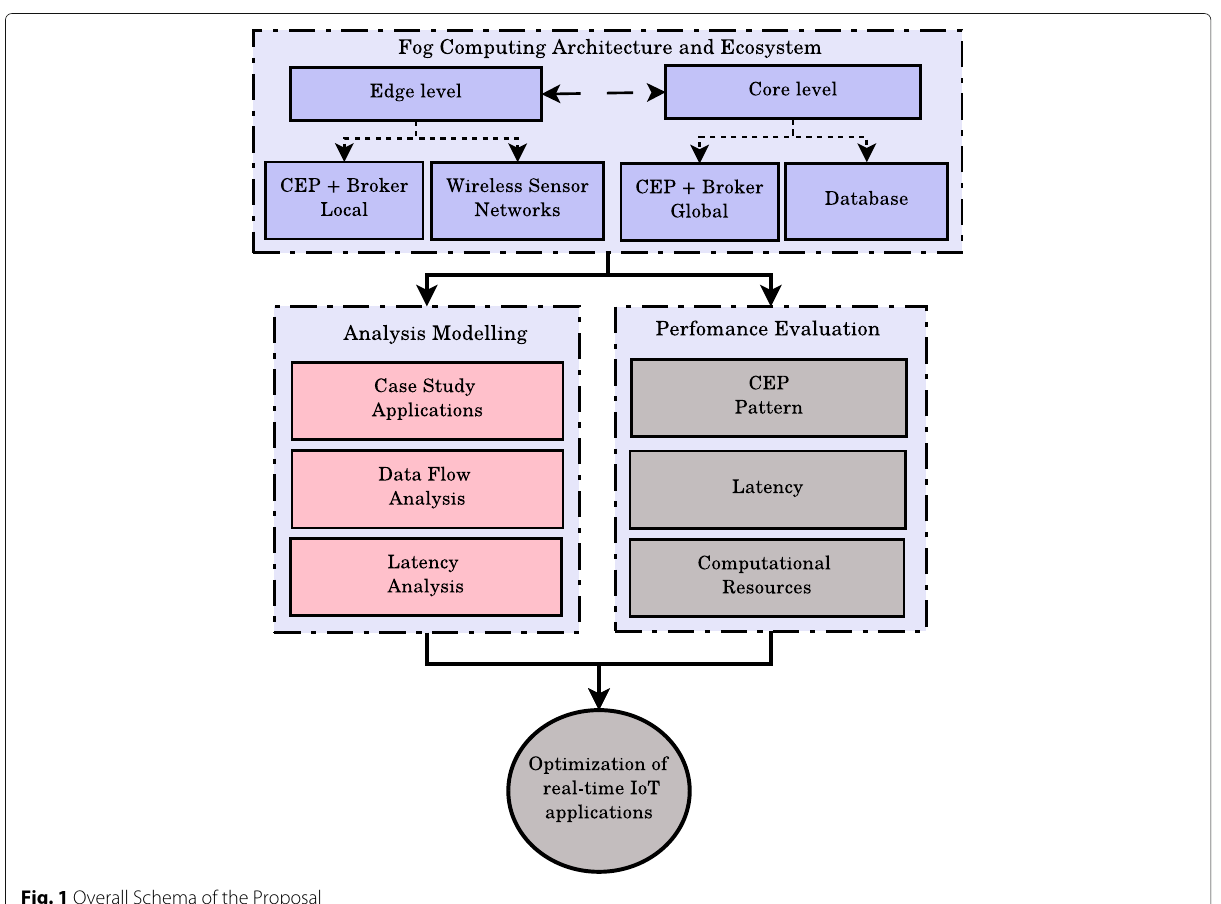
Fig. 1 Overall Schema of the